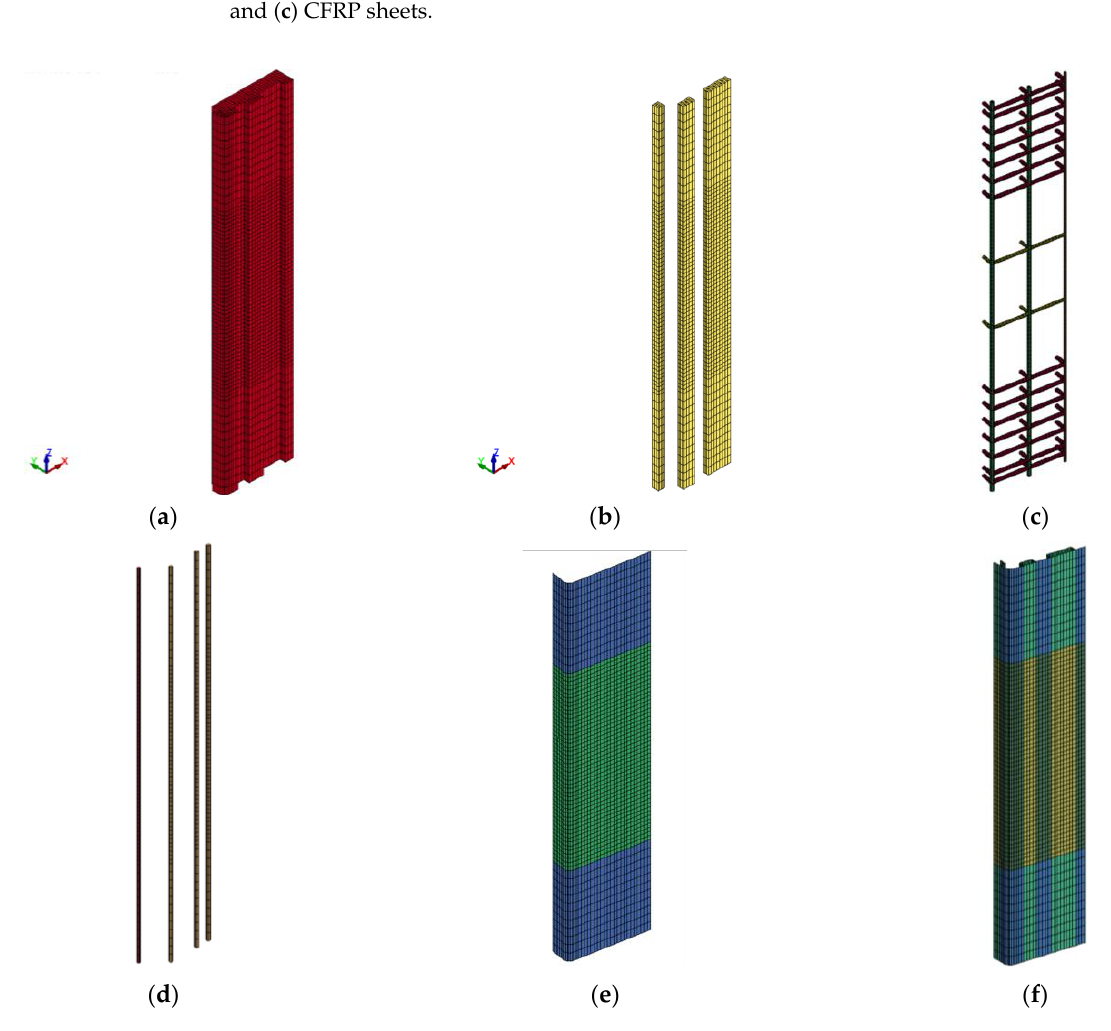
Figure 17. FE mesh for strengthened columns SW2, SW3, and SW4: ( a ) concrete volume; ( b ) epoxy adhesive mortar; ( c ) reinforcement cage; ( d ) NSM rebars; ( e ) CFRP sheets for specimen SW2; and ( f ) CFRP sheets for specimens SW3 and SW4.